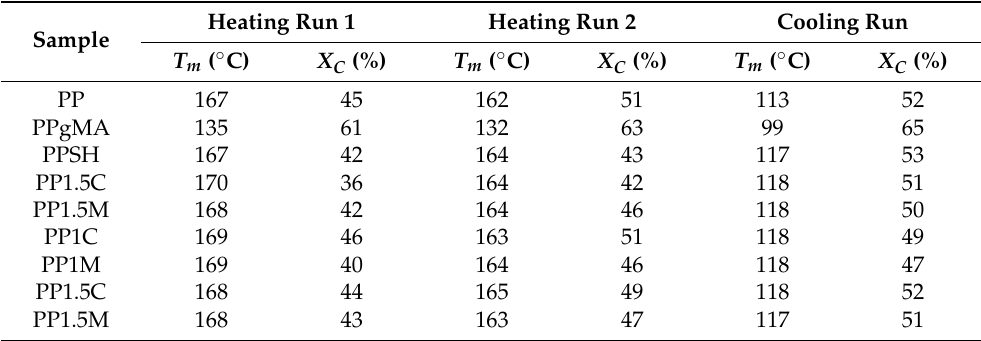
Table 2. Calorimetric properties of the investigated PP and PP